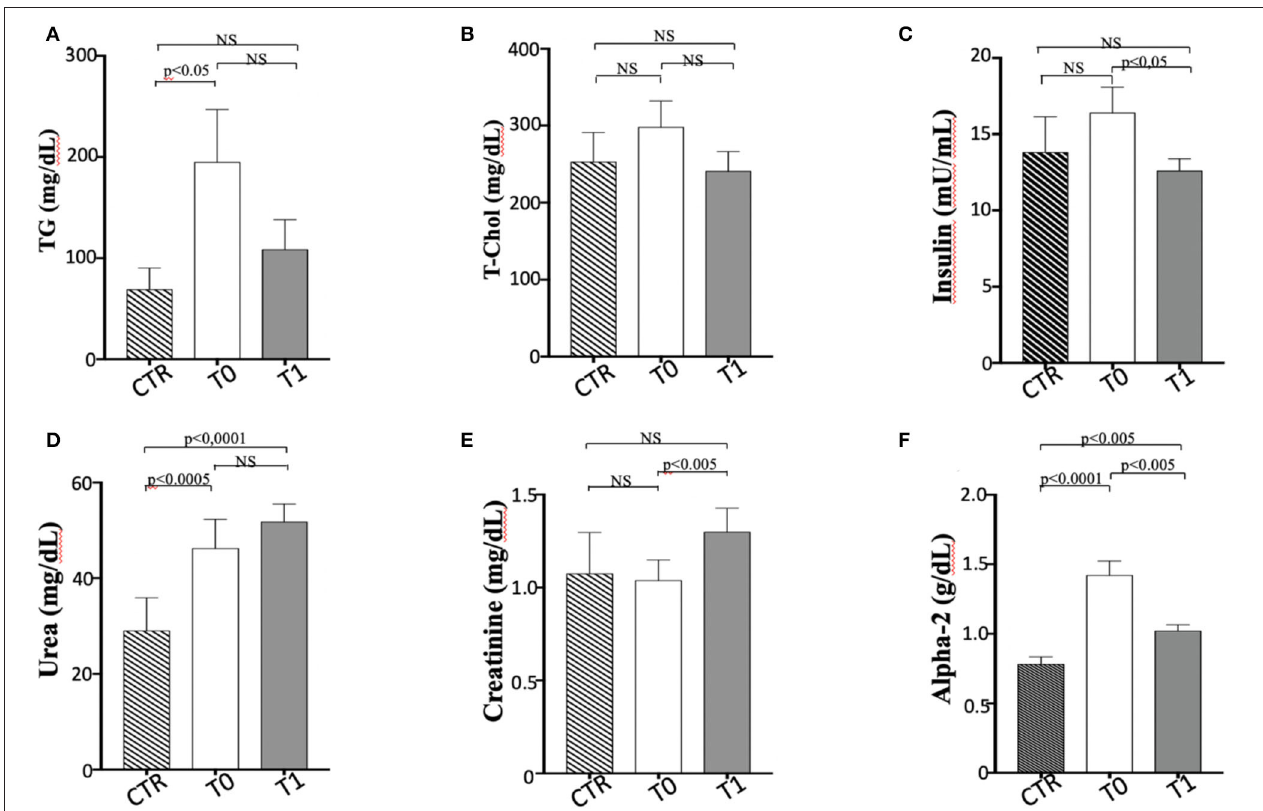
FIGURE 2 | Biochemical parameters in enrolled dogs. (A) TG, Triglycerides; (B) T-Chol, total cholesterol; (C) Insulin; (D) Urea; (E) Creatinine; (F) Alpha 2-globulins. Control (CTR) group, dashed column; obese dogs at T0, white column; obese dogs at T1, gray column. Statistics: Wilcoxon matched-pairs signed-rank test was used for T0 and T1 comparation in obese dogs, while Mann-Whitney test was performed for the comparation between T0 obese dogs and CTR subjects. NS means not significant difference.